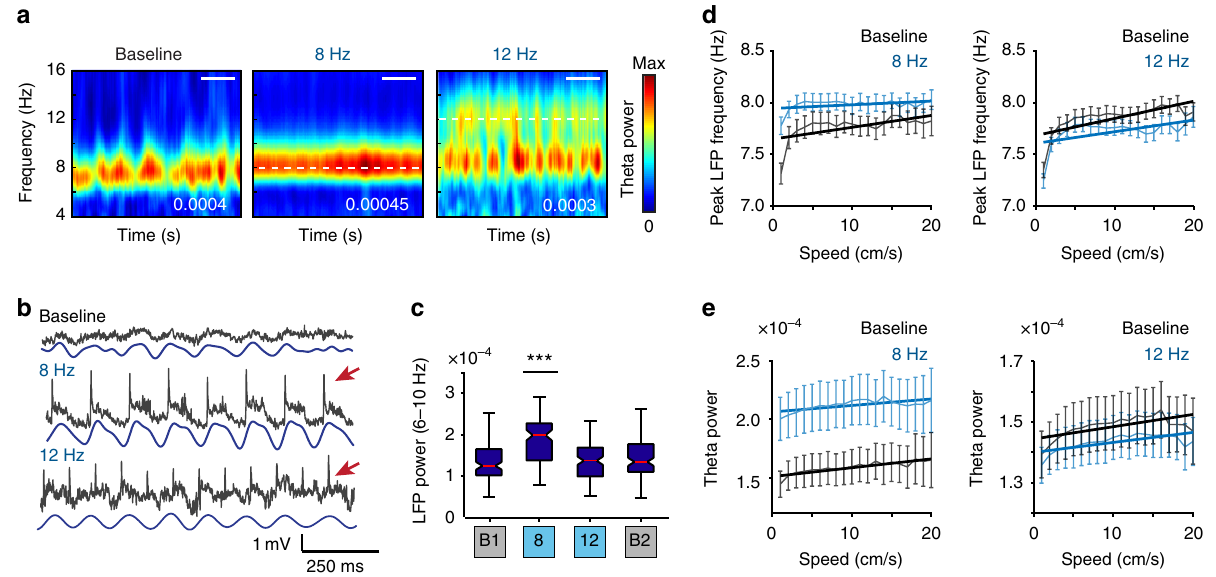
Fig. 4 Speed modulation of theta oscillations was preserved during LIIP activation. a Spectrograms of wavelet power for an example baseline, 8 Hz, and 12 Hz stimulation session. The peak power is on the bottom right, and the white dashed line highlights the stimulation frequency. Scale bar, 50 s. b Example raw (gray) and fi ltered (blue) LFP traces during baseline, 8 Hz, and 12 Hz stimulation sessions, where population spikes (example shown by a red arrow) distorted the raw LFP signal during stimulation. For 12 Hz stimulation sessions, fi ltering the LFP between 6 and 10 Hz eliminated distortion of the signal by population spikes. c Average wavelet power con fi rms that endogenous theta power was not altered during 12 Hz stimulation. Light-induced population spikes distorted the signal during 8 Hz stimulation sessions, leading to arti fi cially high LFP power in the theta frequency range [boxes, median± 25th percentile, whiskers, min. to max.; one-way ANOVA, n (session) = 121 (B1), 37 (8 Hz), 58 (12 Hz), and 120 (B2) across 7 mice, F (3,335) = 7.001, p = 0.0001]. Tukey ’ s multiple comparisons test, *** p < 0.001. d Linear regression of running speed versus peak theta frequency between 6 and 10 Hz for baseline (left, gray) or 8 Hz sessions (left, blue) and baseline (right, gray) or 12 Hz sessions (right, blue). The two slopes were not different from each other in either stimulation condition [ANCOVA, 8 Hz: n = 37 sessions across 7 mice, F (1,36) = 3.407, p = 0.0731, 12 Hz: n = 58 sessions across 7 mice, F (1,36) = 0.7171, p = 0.4027]. e Linear regression of running speed versus mean theta power between 6 and 10 Hz for all baseline (left, gray) or 8 Hz sessions (left, blue) and baseline (right, gray) or 12 Hz sessions (right, blue). The two slopes were not different from each other in either stimulation condition [ANCOVA, 8 Hz: n = 37 sessions across 7 mice, F (1,36) = 1.461, p = 0.2347, 12 Hz: n = 58 sessions across 7 mice, F (1,36) = 0.5918, p = 0.2928]. Plots